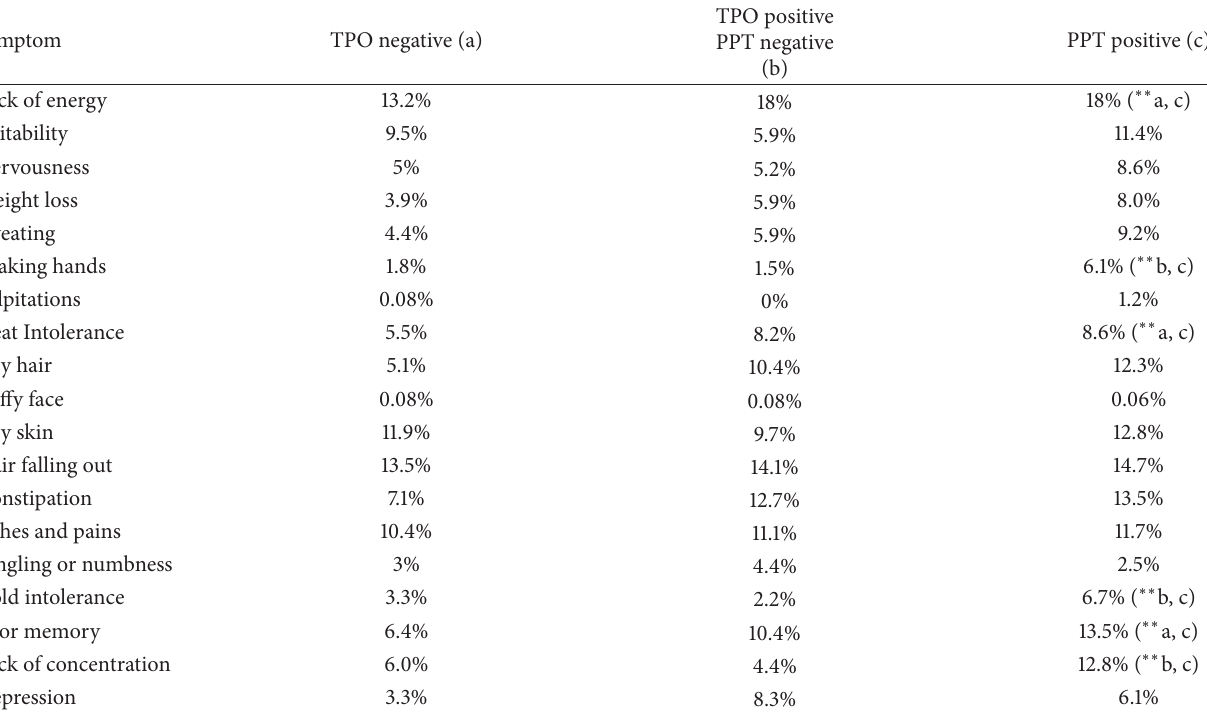
∗∗ indicate 𝑃 < 0.003